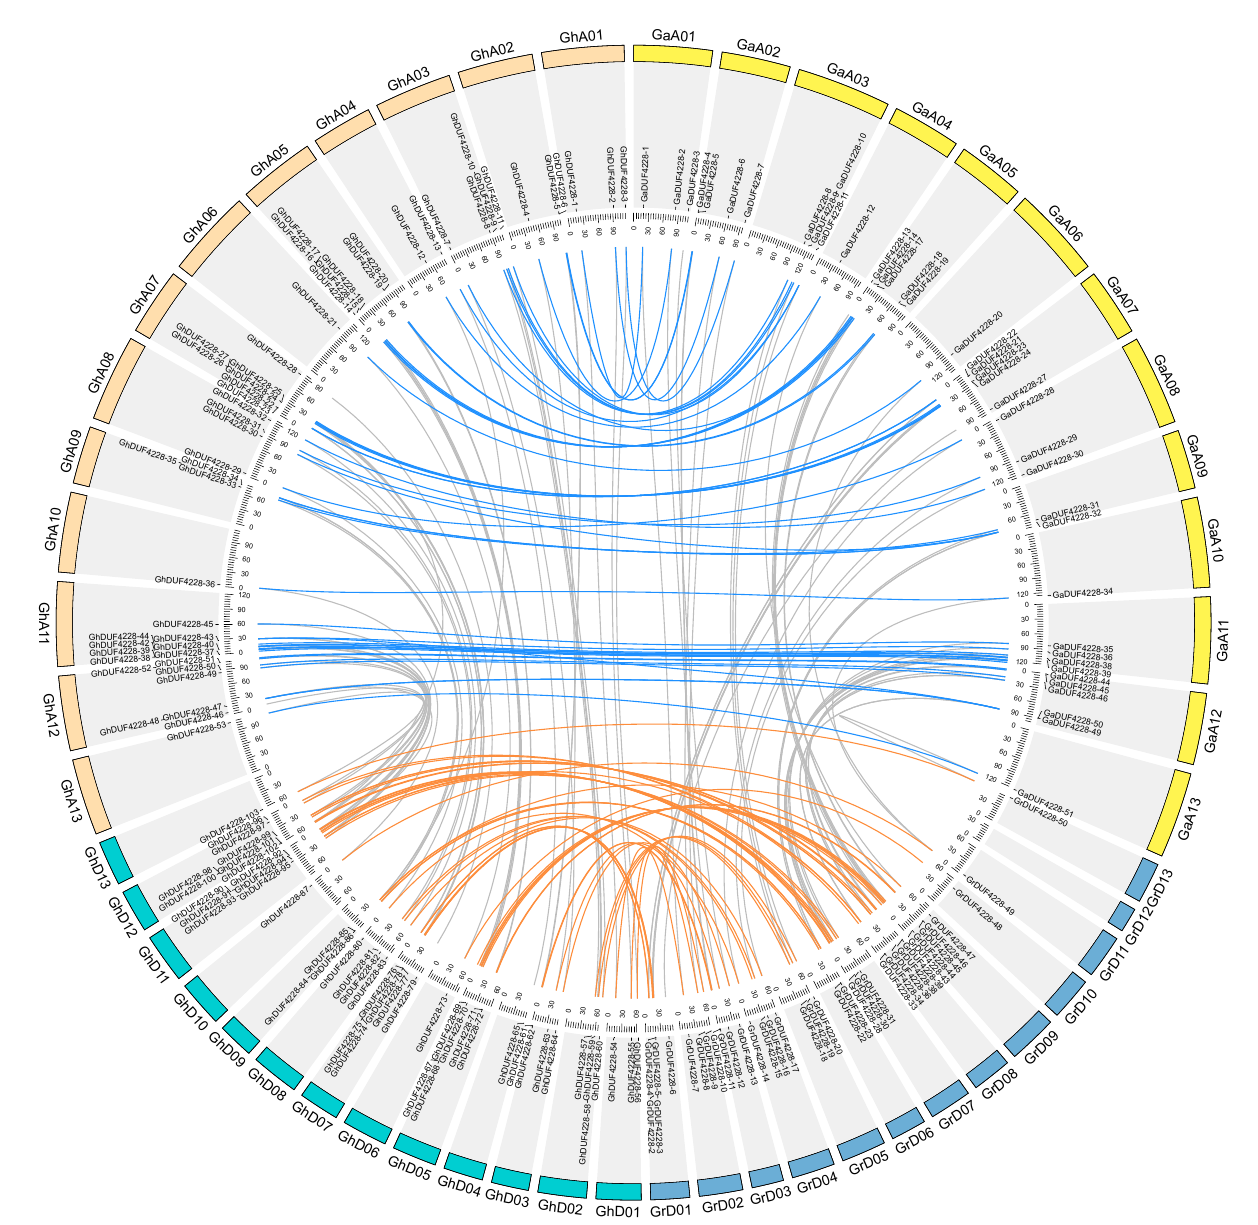
Figure 3. Chromosome distribution and collinearity of duplicated gene pairs of DUF4228 genes. Chro- mosomes are represented by differently colored boxes, distributed in the outer circle. Collinear gene pairs between GhDUF4228 genes and GaDUF4228 genes, between GhDUF4228 and GrDUF4228 genes, are represented by blue and orange lines,